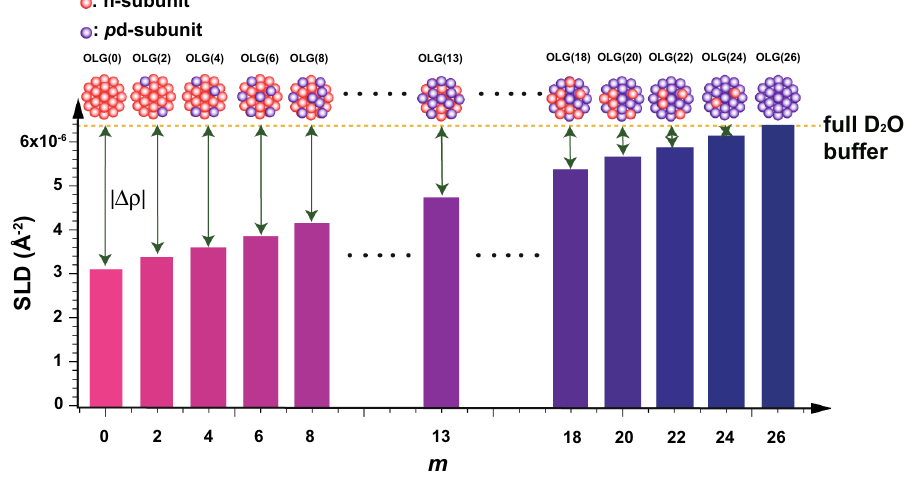
Figure 1. SLDs of OLG( m ) (bars) and full D 2 O buffer (yellow dotted line). The pink and purple spheres correspond to the h- and p d-subunits, respectively. The double-sided arrows indicate the absolute values of the scattering contrast (|Δ ρ |). This figure is prepared by the usage of IGOR Pro 6.34A (https ://www.wavem etric s.com/forum /news-and-annou nceme nts/igor-634a-now-shipp ing) and Adobe Illustrator CC 2015.2.1